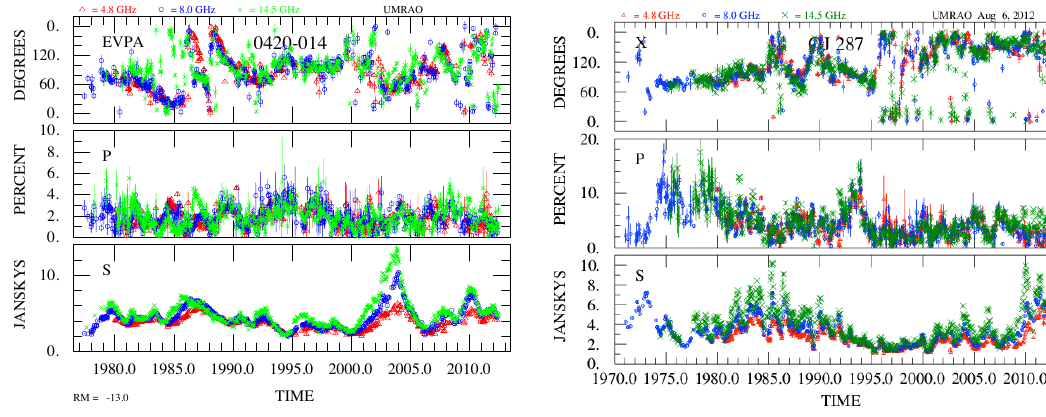
Figure 3. Example of EVPA rotations in the quasar 0420-014 ( Left ) and in the BL Lac object OJ 287 ( Right ). Due to n π ambiguities in the EVPA determination, the range is restricted to 180 ◦ in these